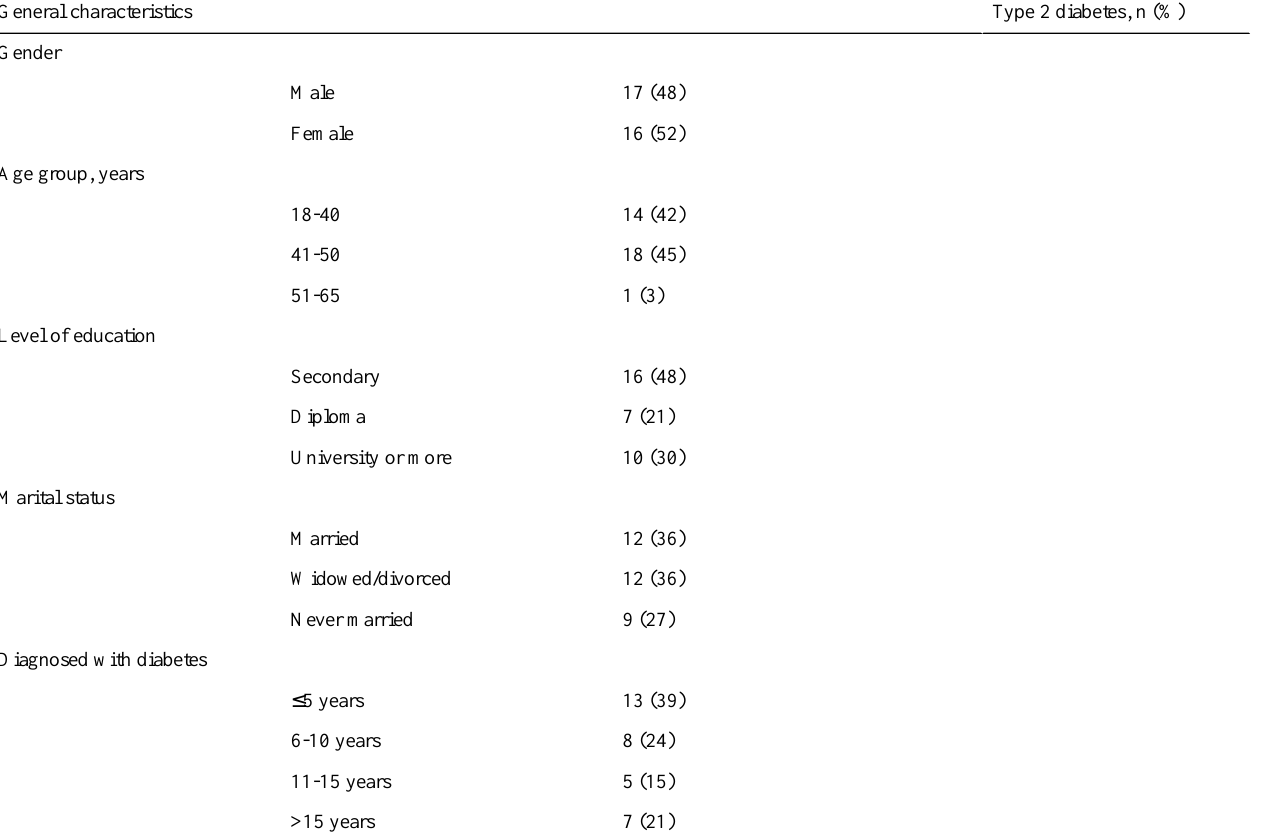
Table 1. Patient demographics of the usability study